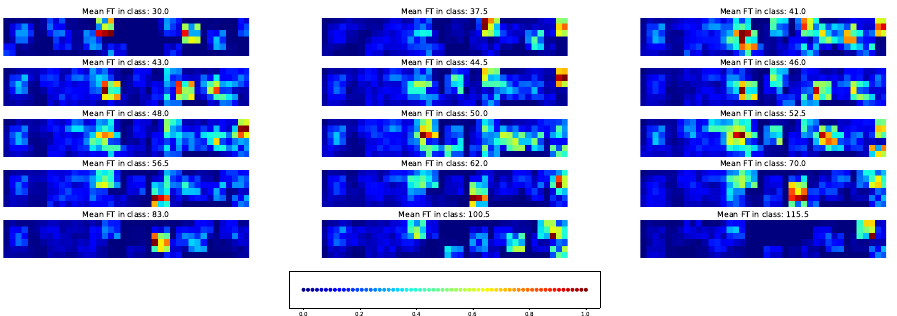
Figure 15. Average saliency maps for time classes and the union SNP set. Figure S6 gives the same data with higher magnification.